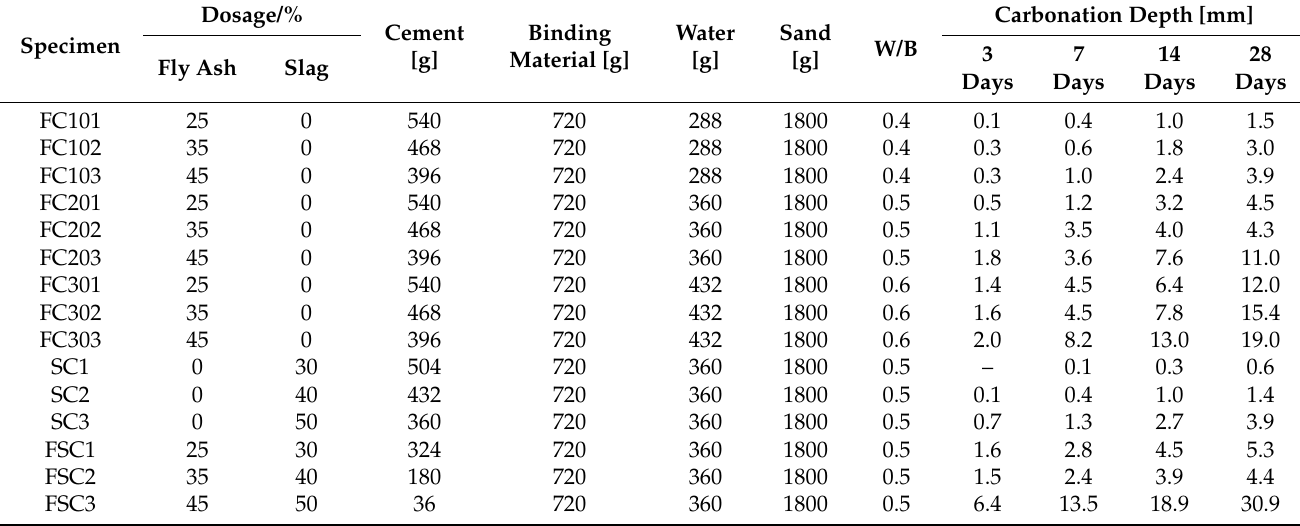
Table 1. Mix proportions of mineral admixture cement based materials and carbonation